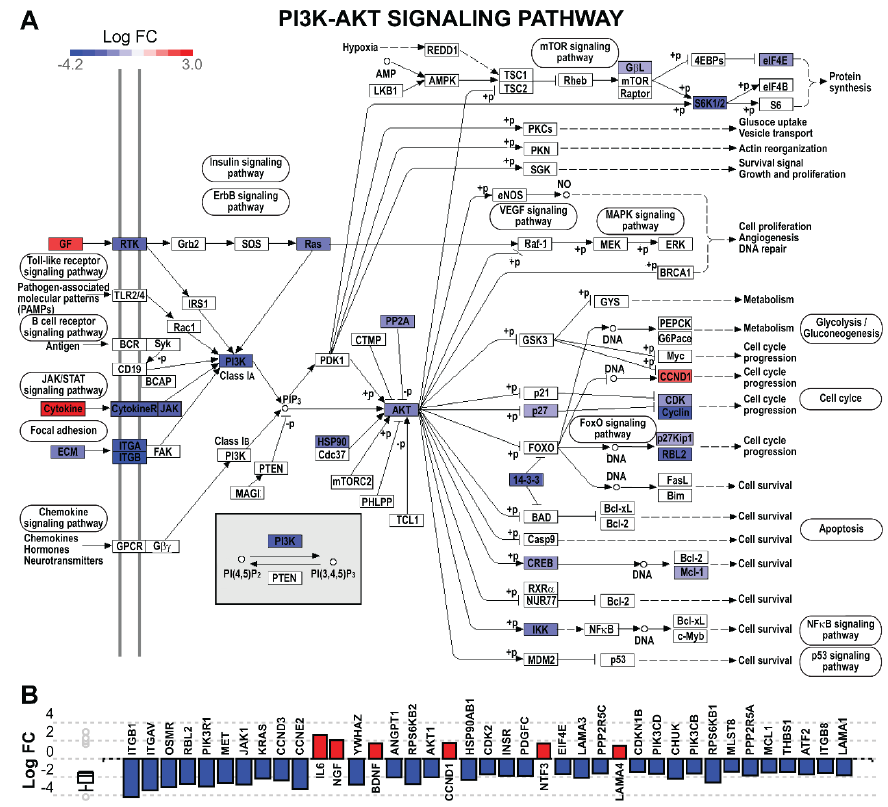
Figure 6. The PI3K-Akt signaling pathway is downregulated in U87 glioblastoma cells overexpressing ZNF554 . ( A ) The Kyoto Encyclopedia of Genes and Genomes (KEGG) pathway diagram (KEGG: 04151) is overlaid with the computed log fold change of each gene. The downregulation is shown in dark blue, and the upregulation in dark red. The legend describes values on the gradient. ( B ) Gene log fold change bar plot. All genes in the PI3K-AKT signaling pathway were ranked according to log fold change, negative values were depicted in blue and positive values in red. The box and whisker plot on the left summarizes the distribution of all gene perturbations in this pathway, the box represents the first quartile, median and third quartile, while circles represent outliers. Akt serine/threonine kinase, Akt; phosphatidylinositol 3-kinase, PI3K. 3. Discussion 3.1. Principal Findings of This Study: (1) ZNF554 shows predominant brain expression with low region specificity in humans; (2) in adult diffuse gliomas, ZNF554 mRNA and protein expressions decrease with increasing tumor grade; (3) low ZNF554 mRNA expression is associated with shorter survival of anaplastic astrocytoma and glioblastoma patients, and also when all gliomas are analyzed together; (4) the overexpression of ZNF554 results in the dysregulation of 899 genes in U87 glioblastoma cells, and most of these are downregulated; (5) among 116 dysregulated pathways, 73 are cancer-related and 86 are immune-related (49 pathways are common), and these are mostly downregulated; and (6) the overexpression of ZNF554 decreases cell proliferation and induces cell cycle arrest.